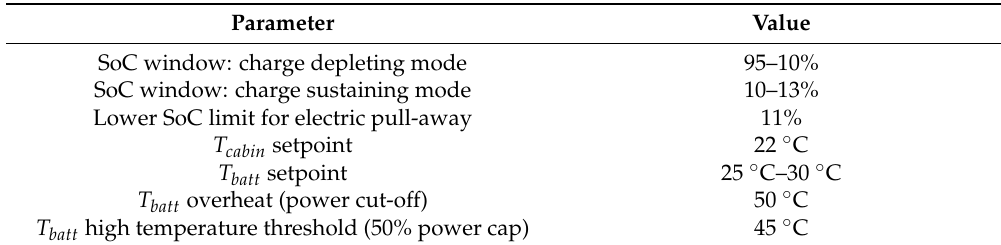
Table 3. Control parameters adopted from the target vehicle